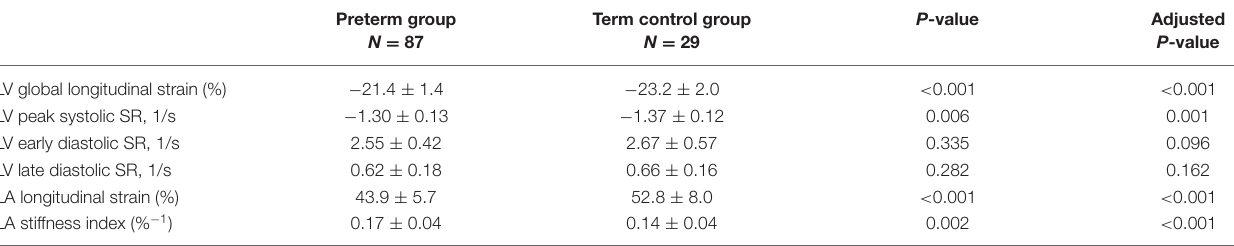
TABLE 4 | 2DSTE echocardiographic results of the preterm children compared to term